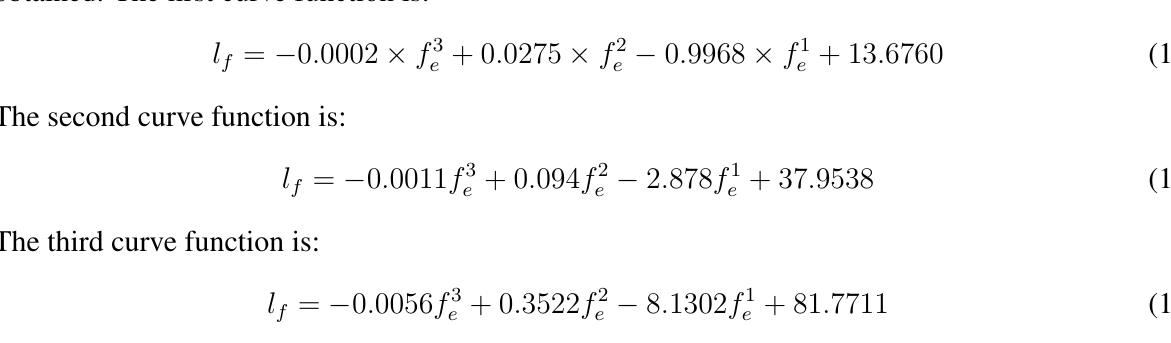
Figure 6. The harmonic frequency curves of f